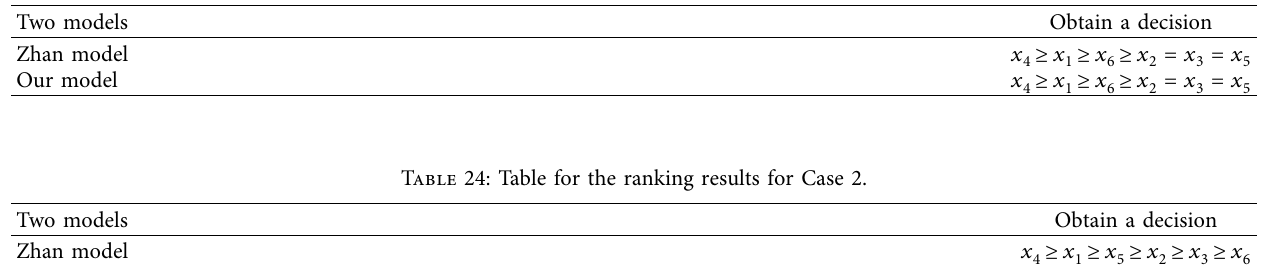
Table 23: Table for the ranking results for Case